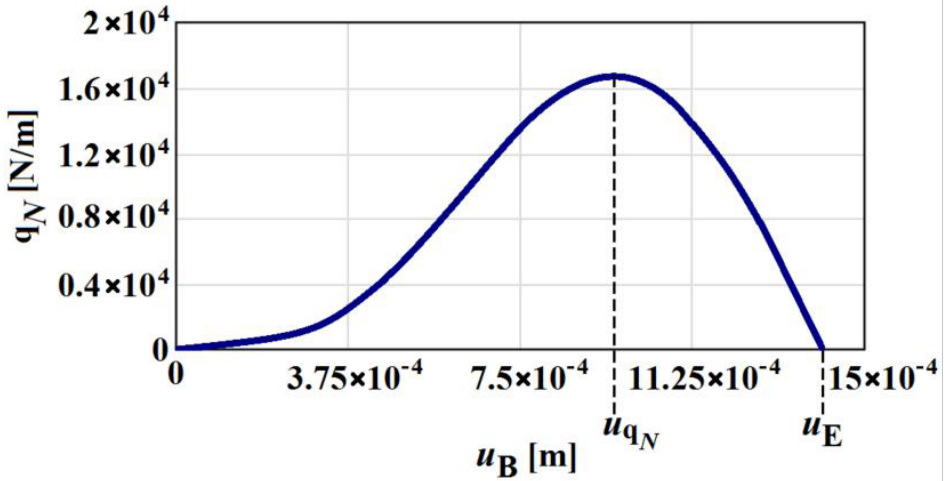
Figure 9. The course of the calculated continuous tangential reaction q N at the base at point B of the screw (measurement No. 1), see Figure